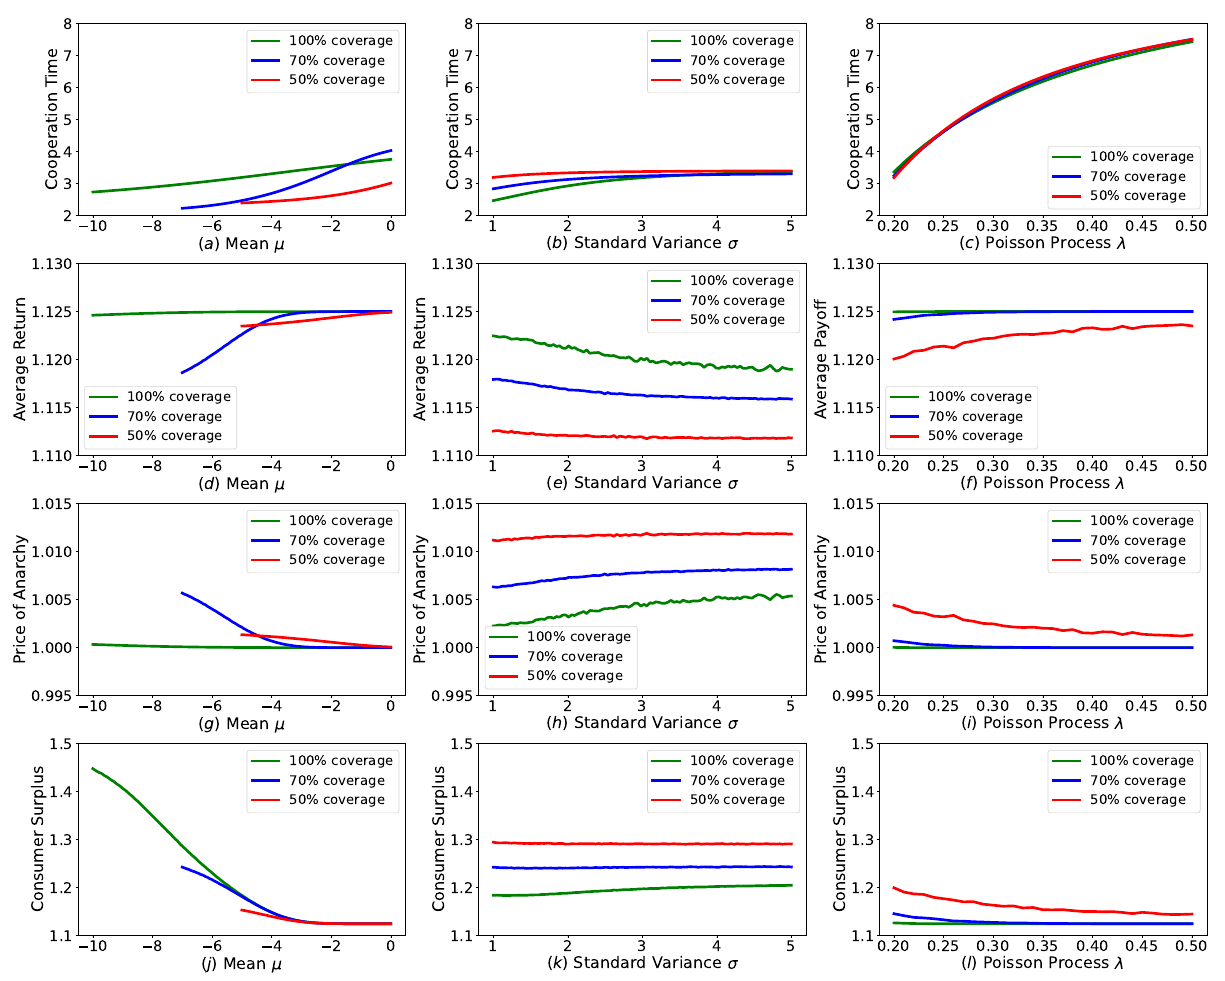
Figure 3. Performances of equilibrium plan in revision Cournot game with various deadline uncer- tainty settings. For each column, we change µ , σ of normal deadline distribution and Poisson process λ , to check how these parameters affect the players’ behavior and payoff in each